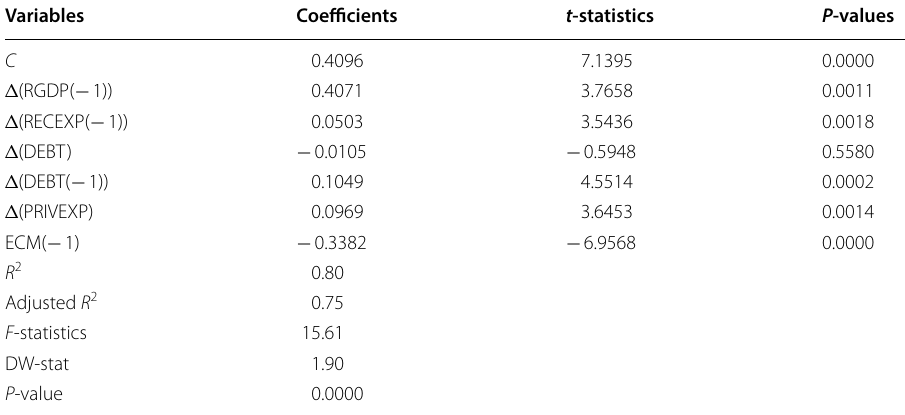
Table 4 Error correction estimates